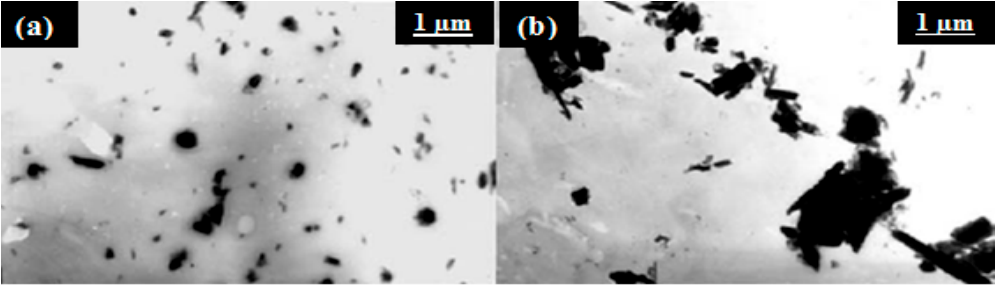
Figure 6. TEM photos of PVA - HNT nanocomposite films (2 wt % HNTs) prepared by: ( a ) coagulation ( b ) casting [3].